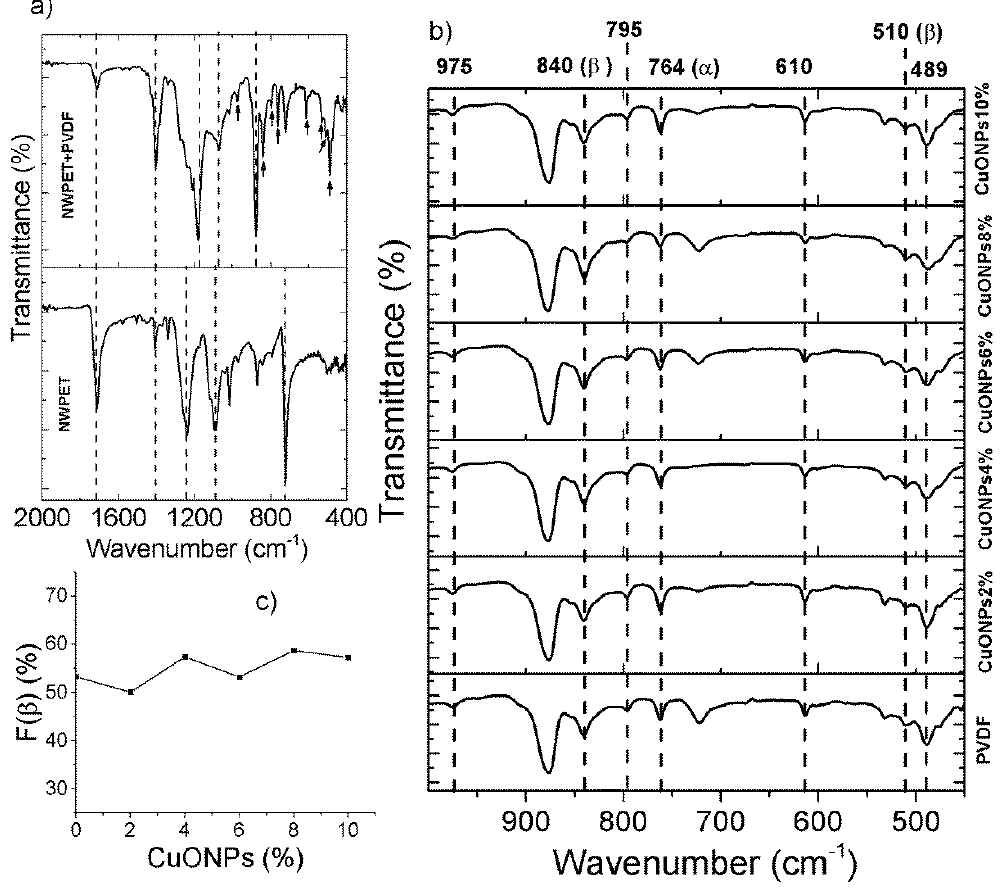
Figure 3. ATR-FTIR spectra of ( a ) neat NWPET and PVDF-covered NWPET and ( b ) NWPET-PVDF membranes prepared at different CuONPs/PVDF compositions. ( c ) Dependence of the β -phase fraction on the CuONPs/PVDF composition.